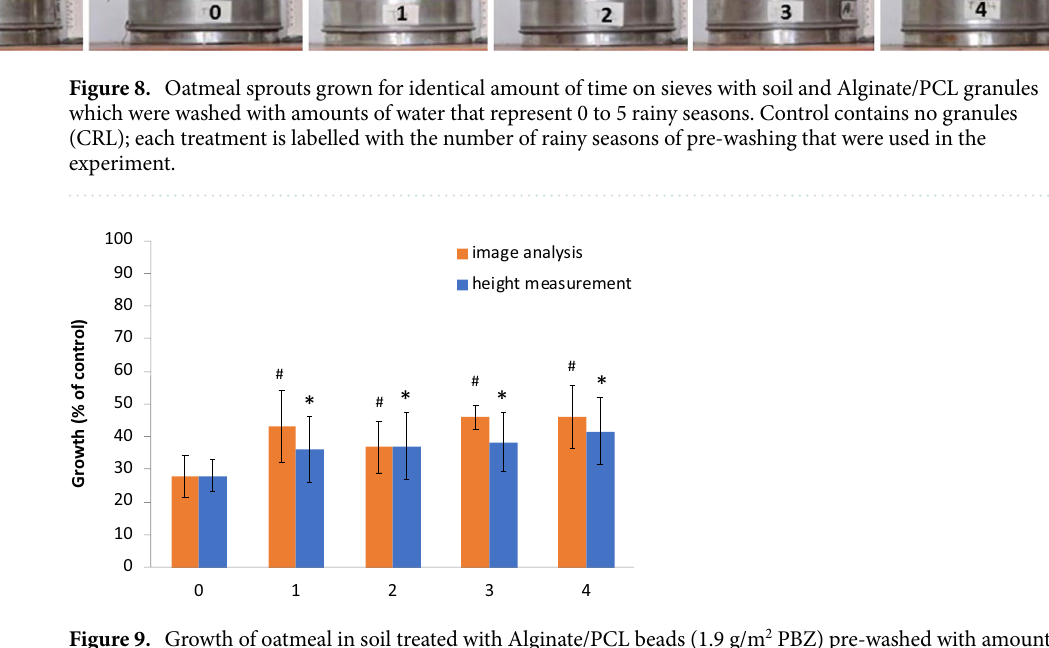
Figure 9. Growth of oatmeal in soil treated with Alginate/PCL beads (1.9 g/m 2 PBZ) pre-washed with amounts of water that represents 0 to 4 rainy seasons. The data is compared to a control treatment without granules. The growth is analyzed using height measurement and image analysis. All treated samples demonstrated a statistically significant growth retardation when compared to the control group (n = 6, p < 0.01); #, * indicate statistically significant difference compared to season 0 treatment for image